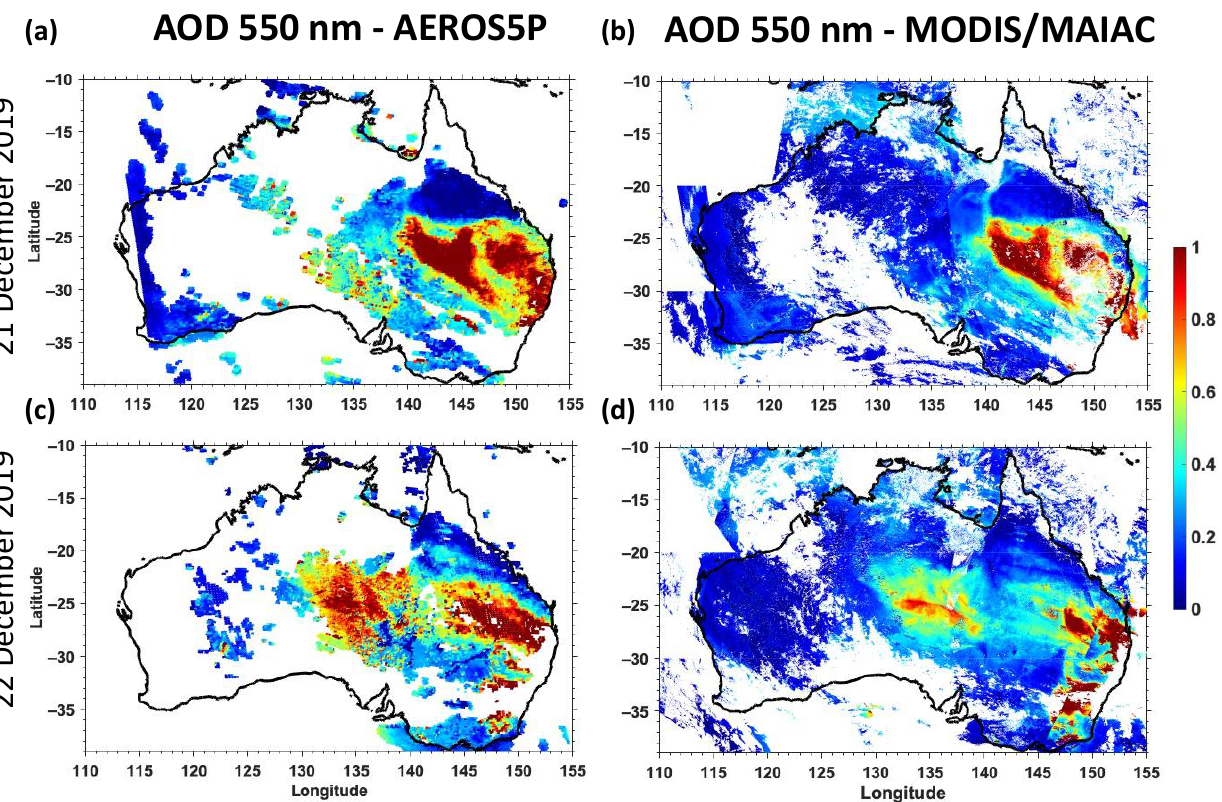
Figure 2. Horizontal distribution of AODs at 550 nm from ( a , c ) AEROS5P and ( b , d ) MODIS using the MAIAC algorithm on ( a , b ) 21 and ( c , d ) 22 December 2019 over Australia. This period was characterized by intense wildfires with large emission of BB aerosols.